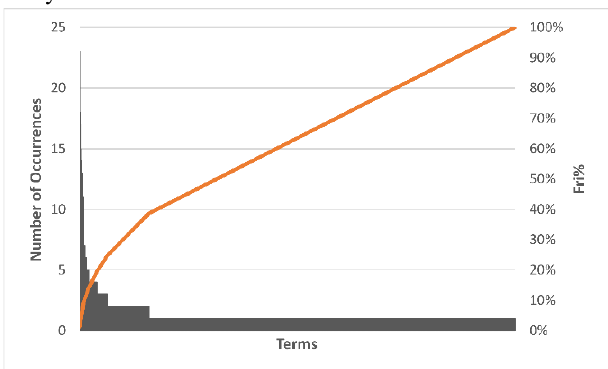
Figure 9. Histogram of the N5 (1.197) terms from IHC.